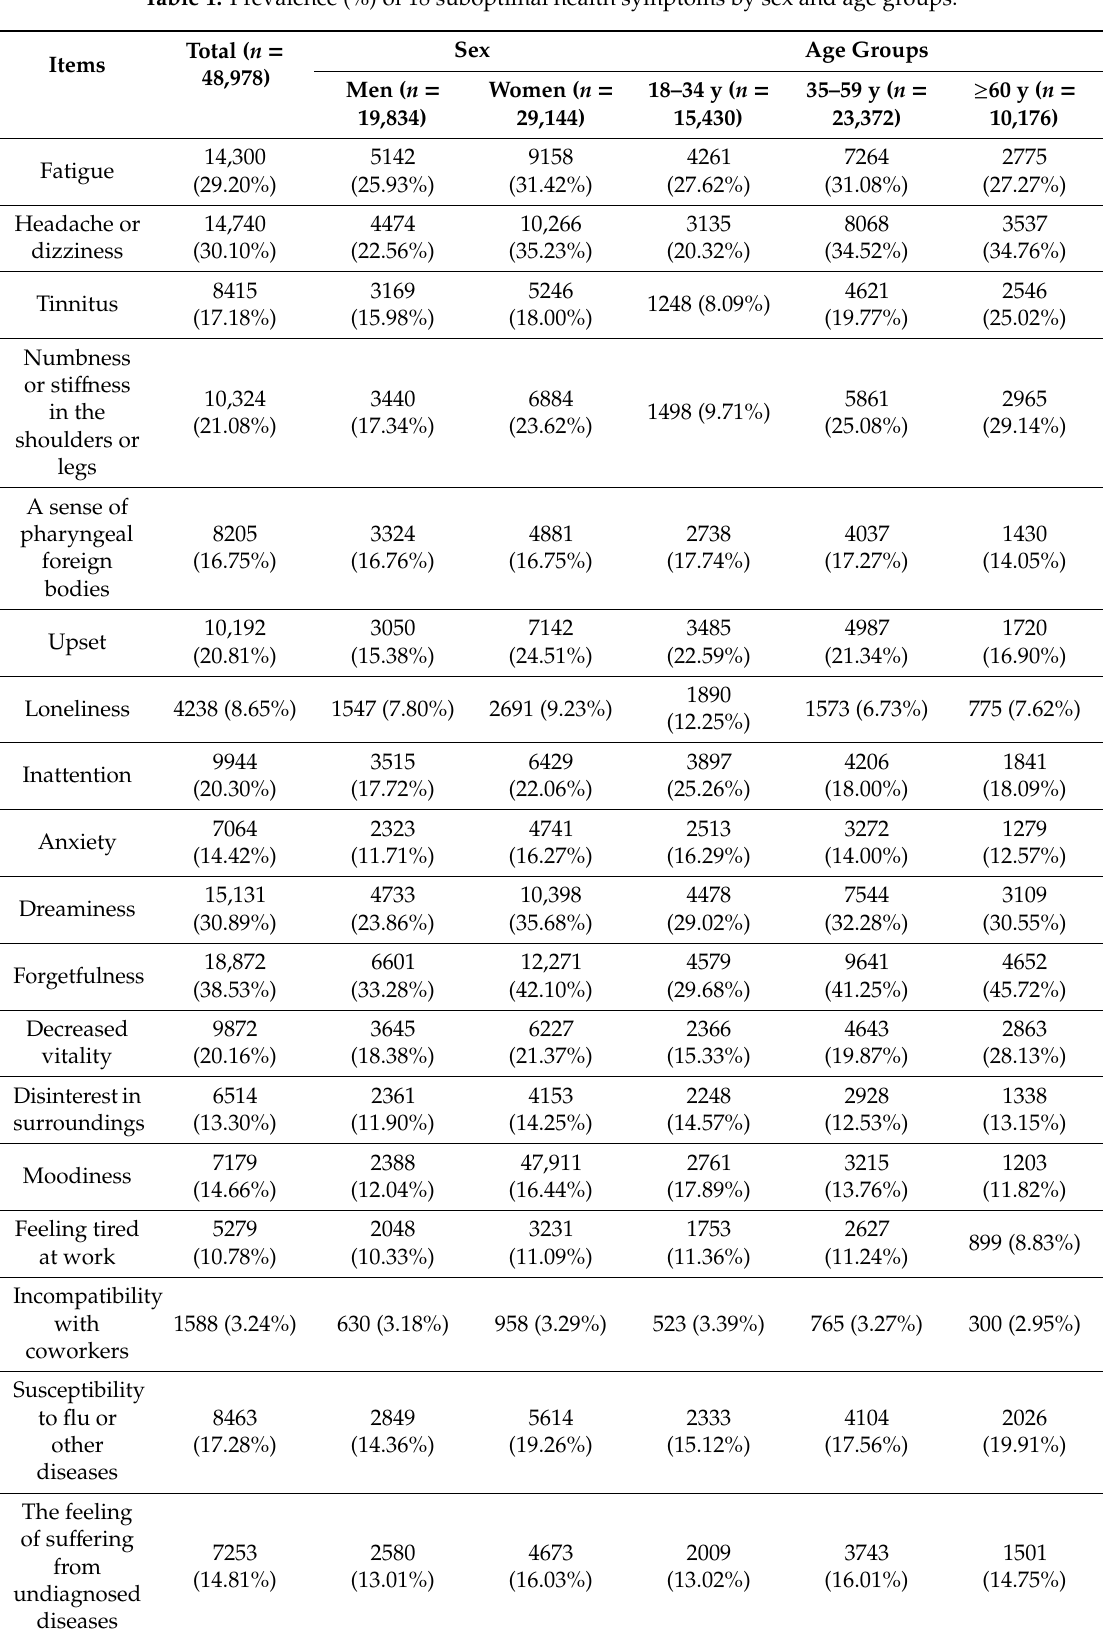
Table 1. Prevalence (%) of 18 suboptimal health symptoms by sex and age